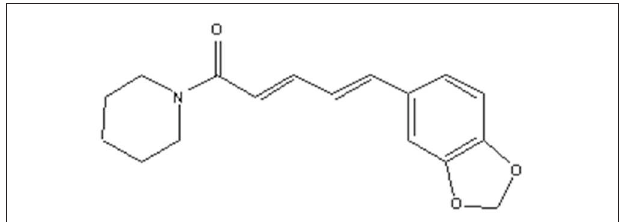
FIGURE 1 | Structure of piperine. Piperine is an alkaloid containing a heterocyclic ring structure and a basic nitrogen atom. Nitrogen atom is located inside the ring